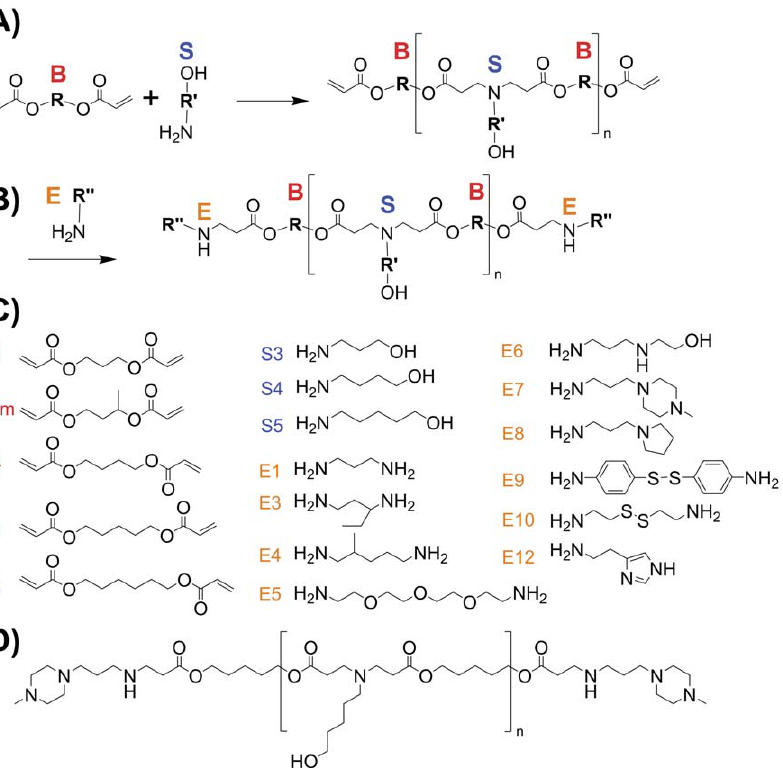
Figure 1. Schematic showing polymerization scheme and monomers used. (A) Diacrylates (‘‘B’’) were added to primary-amine containing amino-alcohol side chains (‘‘S’’) to form the base polymers. (B) Base polymers were end-capped with amine monomers (‘‘E’’) to form the final, end- modified polymers. (C) The base diacrylate (‘‘B’’), amino-alcohol side chain (‘‘S’’), and end-modifying amines (‘‘E’’) used in the polymer library are listed here. (D) The full structure of B5-S5-E7 (1-(3-aminopropyl)-4-methylpiperazine-end-modified poly(1,5 pentanediol diacrylate-co-5-amino-1-pentanol) is shown here.